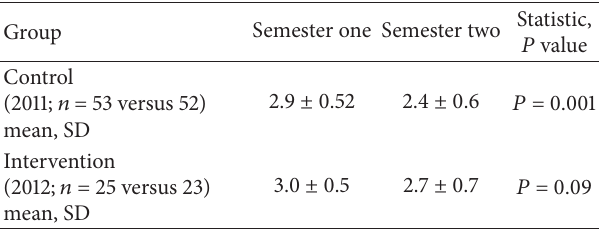
Table 6: Student level of understanding (performance as measured by SOLO scoring) between